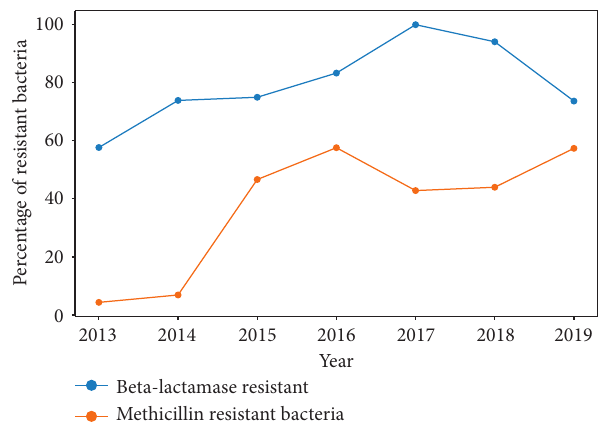
Figure 14: Percentage of resistant bacteria.